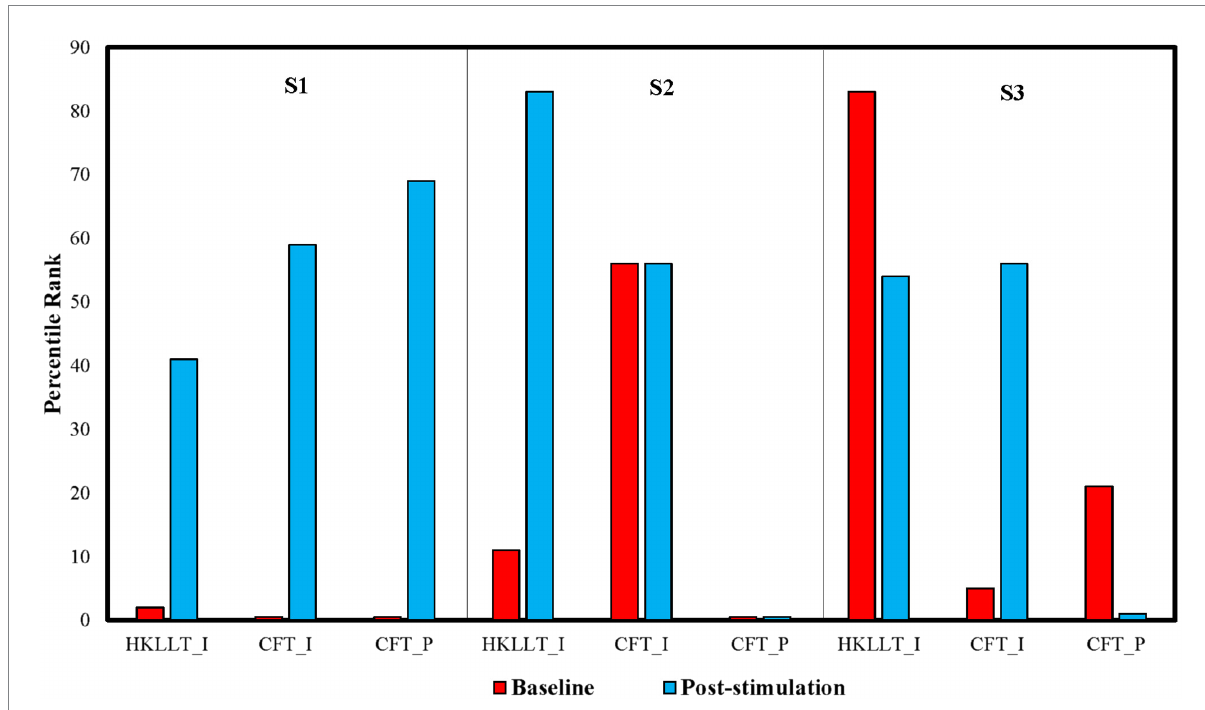
FIGURE 1 Percentile rank of intrusion errors (I) in the Hong Kong list learning test (HKLLT) and the category fluency test (CFT), and perseveration errors (P) in the CFT at baseline and after tPBM.